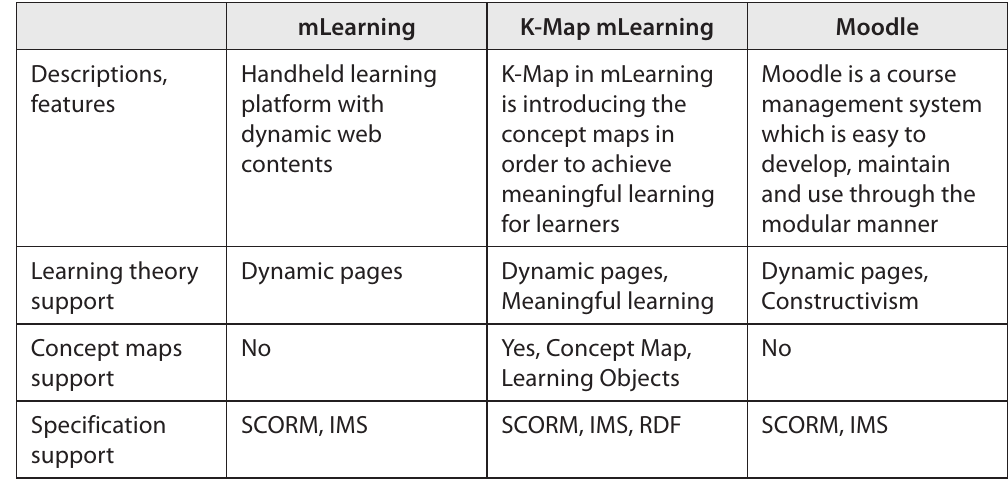
Table 1 Comparison of related research in e-learning